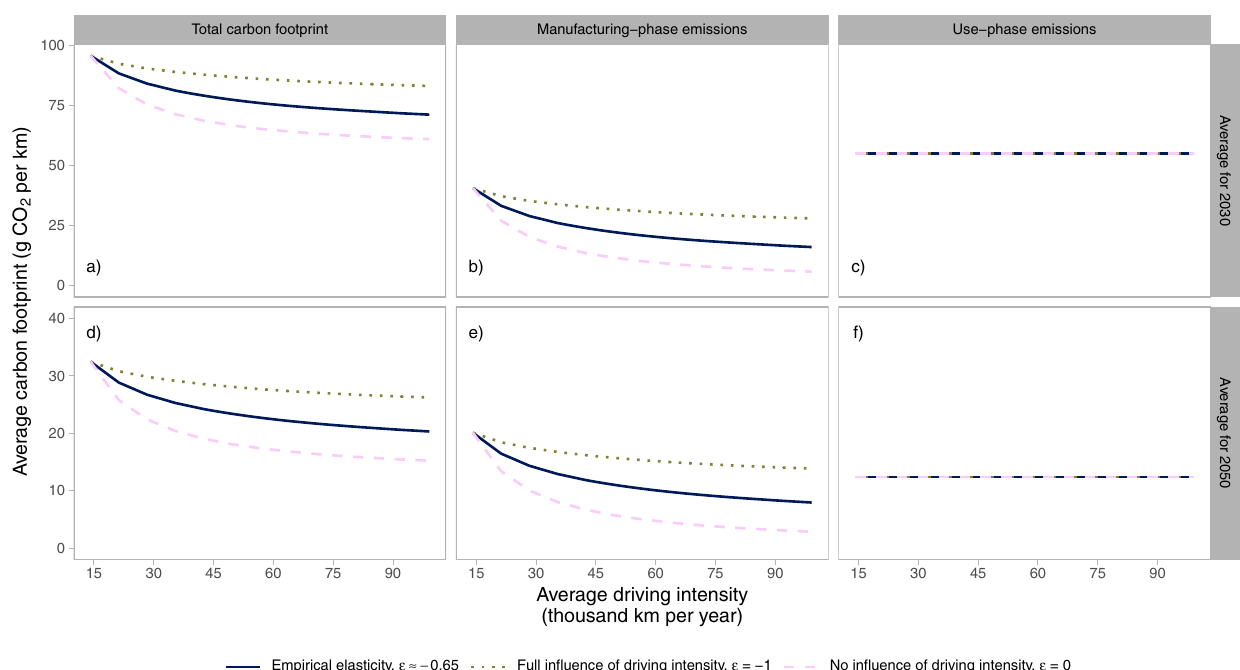
Fig.2|Impactoflifetime-intensitymodeloncarbonfootprint. Resultsshowthe impact on annual average carbon footprints for meeting a certain travel demand: total carbon footprint ( a , d ), manufacturing-phase emissions ( b , e ), and use-phase emissions( c , f )for2030( a – c )andfor2050( d – f ),dependingontheelasticityofthe